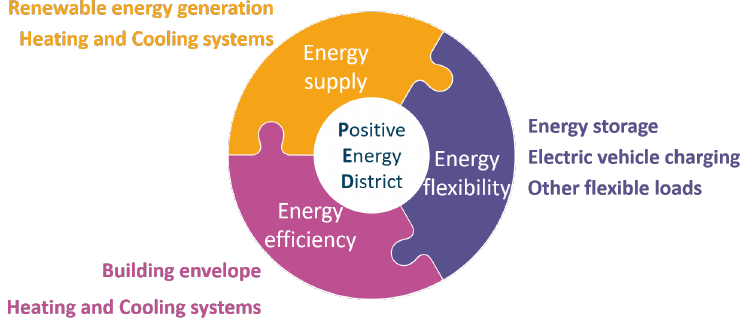
Figure 1. The key concepts/elements of positive energy districts (adapted from